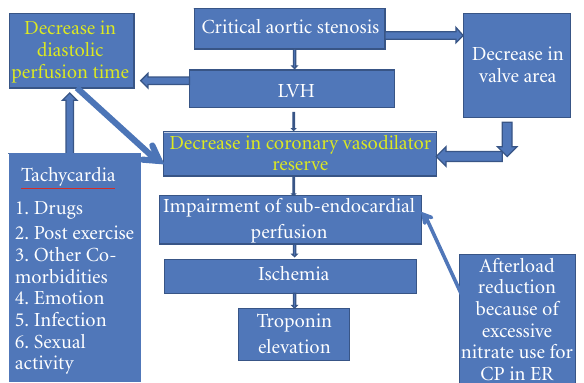
Figure 3: Proposed pathophysiology of troponinemia in our patient with critical aortic